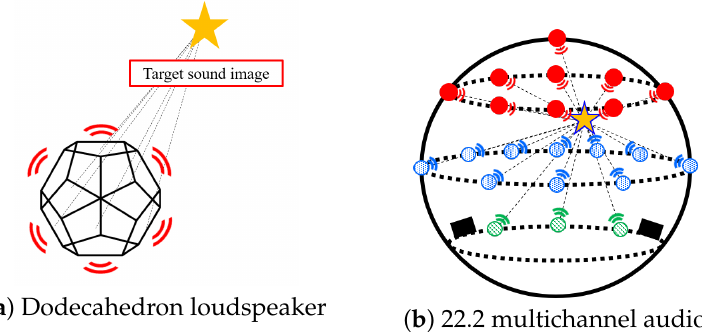
Figure 5. Difference between the position of the target sound image on each